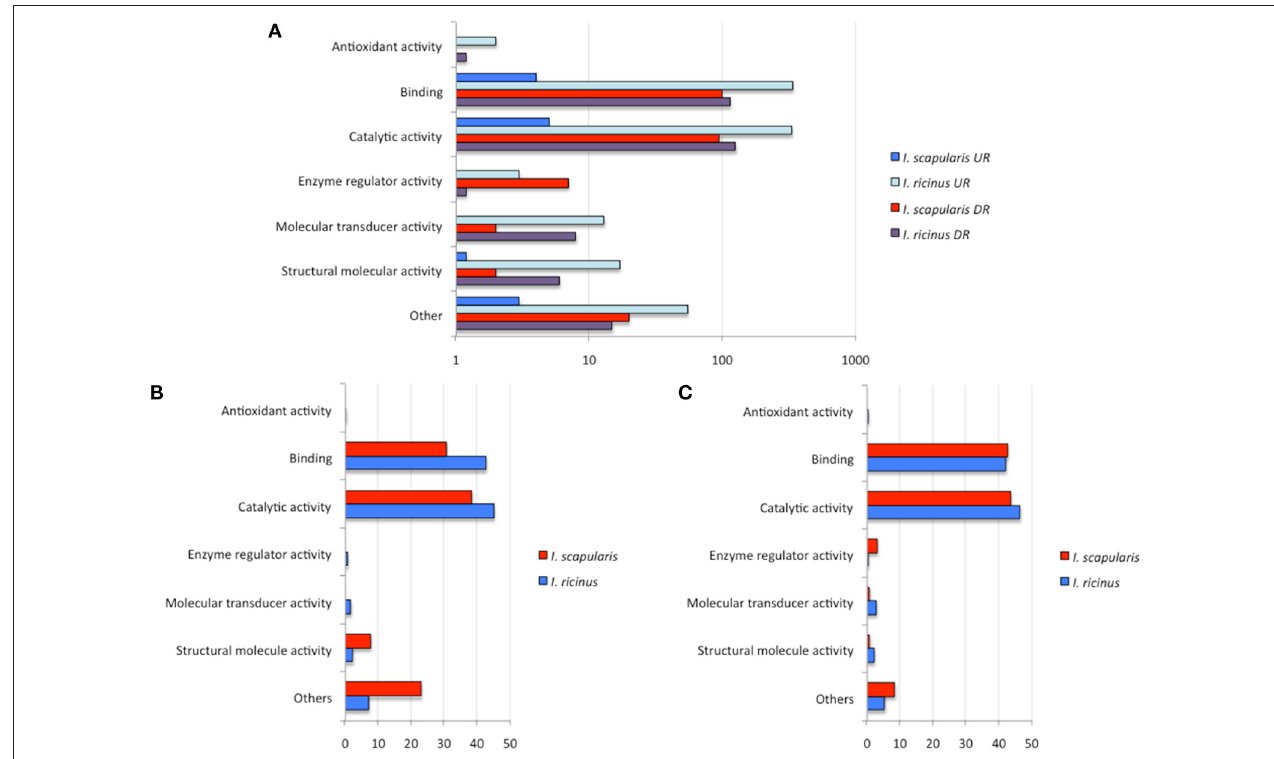
FIGURE 3 | Molecular function of differentially expressed genes in response to A. phagocytophilum infection of I. ricinus IRE/CTVM20 and I. scapularis ISE6 cells. (A) Differentially expressed genes were functionally annotated and grouped according to the MF of the encoded proteins. The number of genes on each MF is shown. (B) Percentage of upregulated genes in each MF. (C) Percentage of downregulated genes in each MF. UR, upregulated genes; DR, downregulated